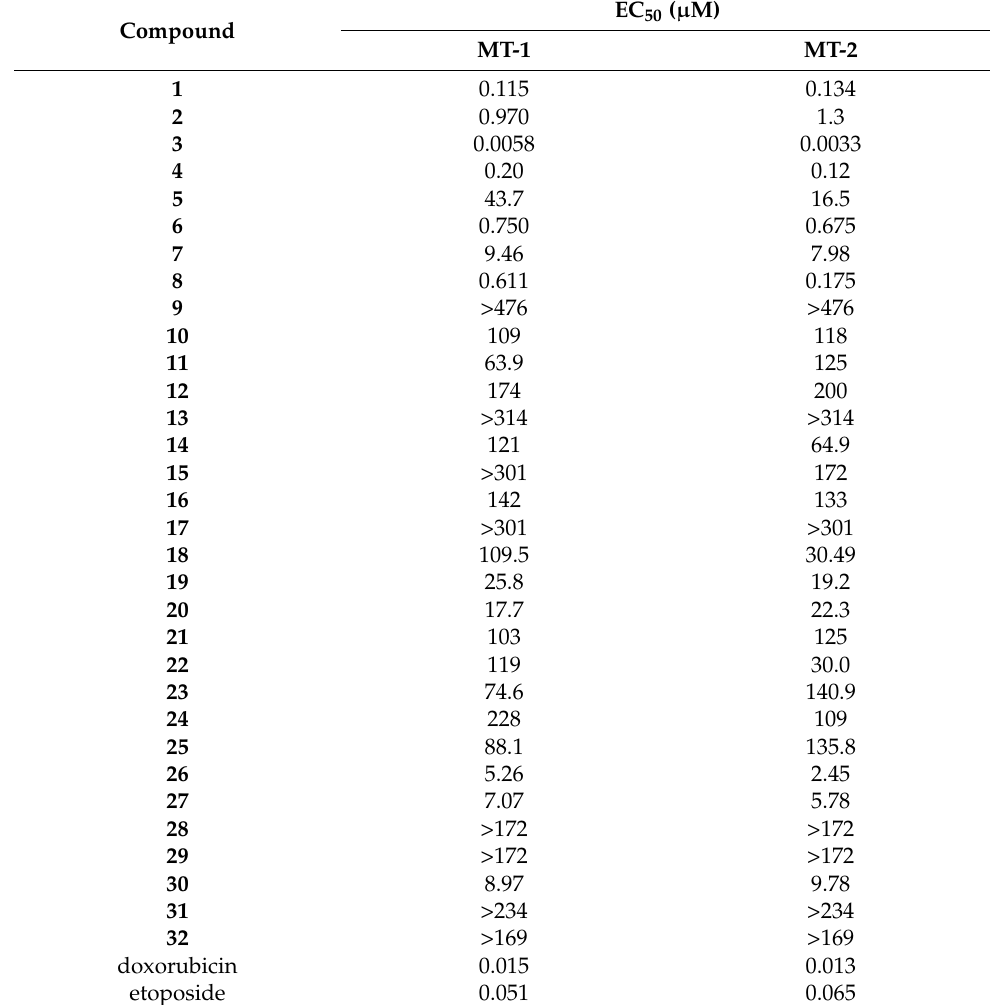
Table 2. Anti-proliferative activity of compounds 1 – 32 , doxorubicin, and etoposide standards (EC 50